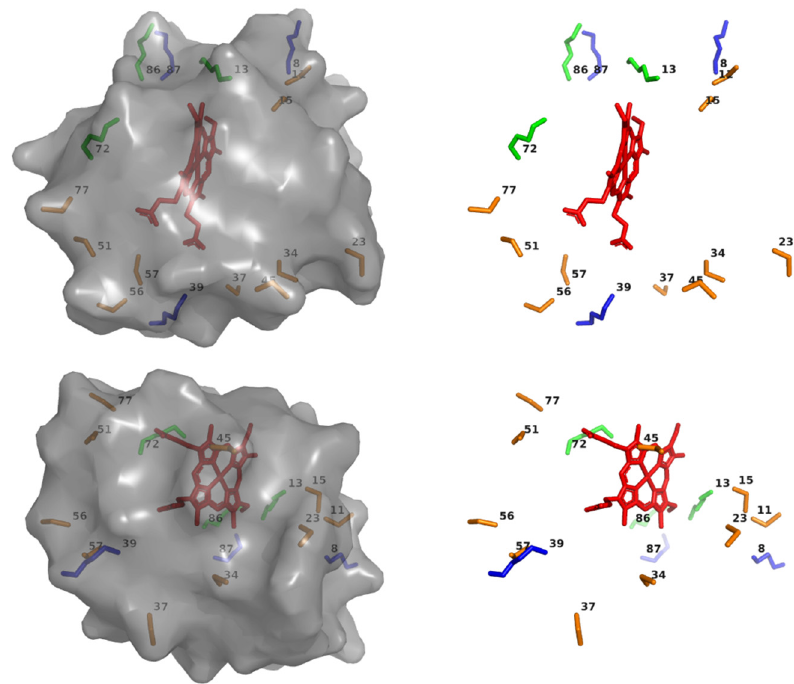
Figure 1. Structure of horse heart cytochrome c , with in silico mutated cysteines and native lysines that were labeled in this study by TUPS. Original structural file: 1HRC.pdb. Two different viewing angles (top and bottom row), with and without the protein surface (left and right) are shown. Color code: cysteines, gold; lysines that were also mutated to cysteines, blue; other lysines, green.